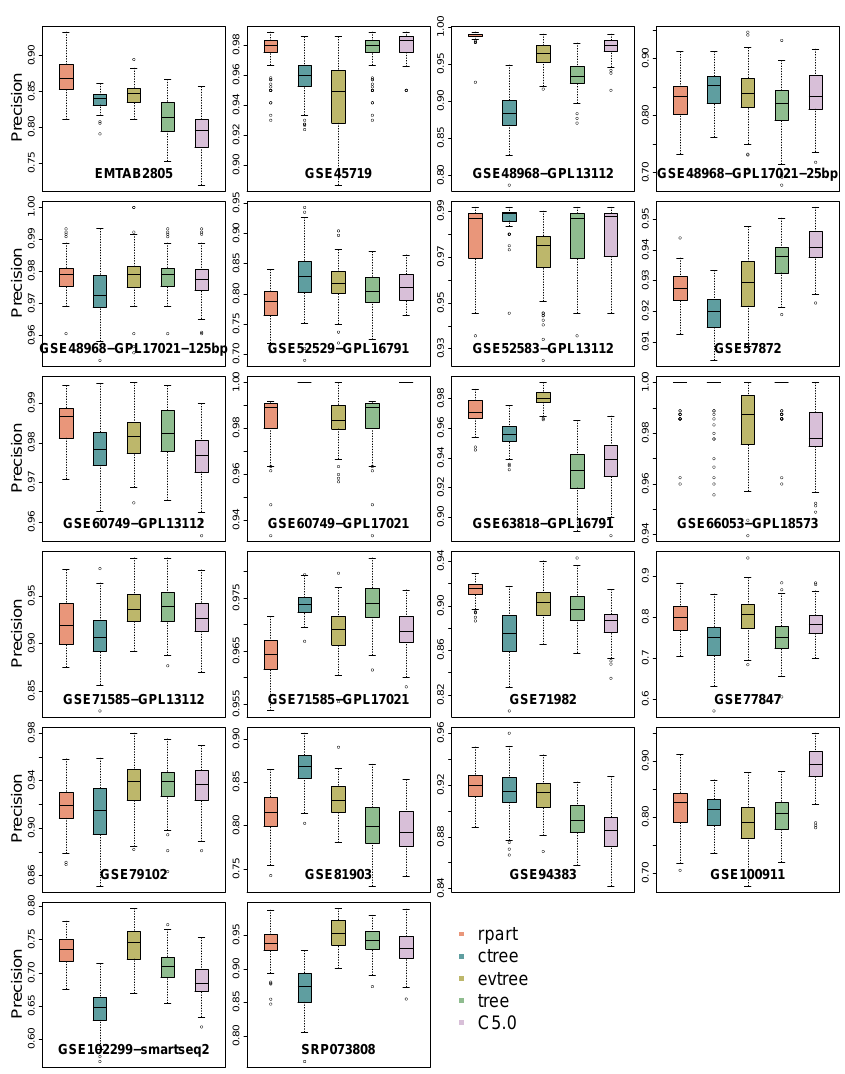
Figure 2. Methods’ Precision scores on all data